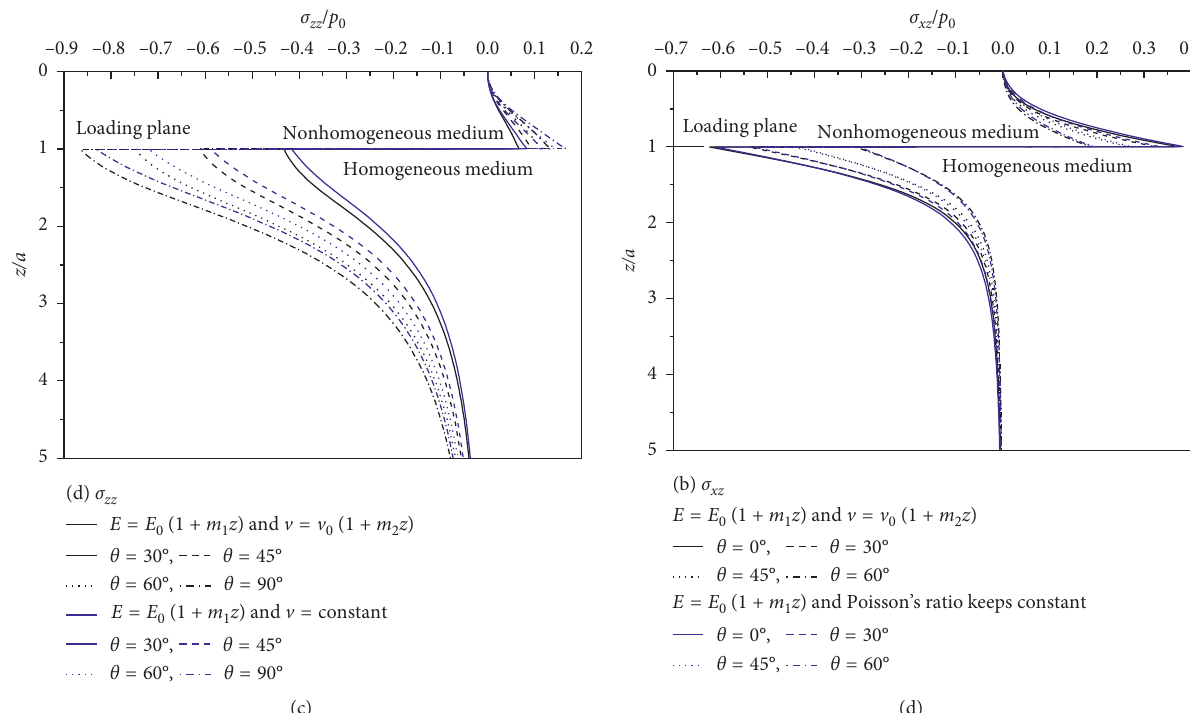
Figure 8: Variations of the four stress components for d � a and h � a for different θ . (a) σ